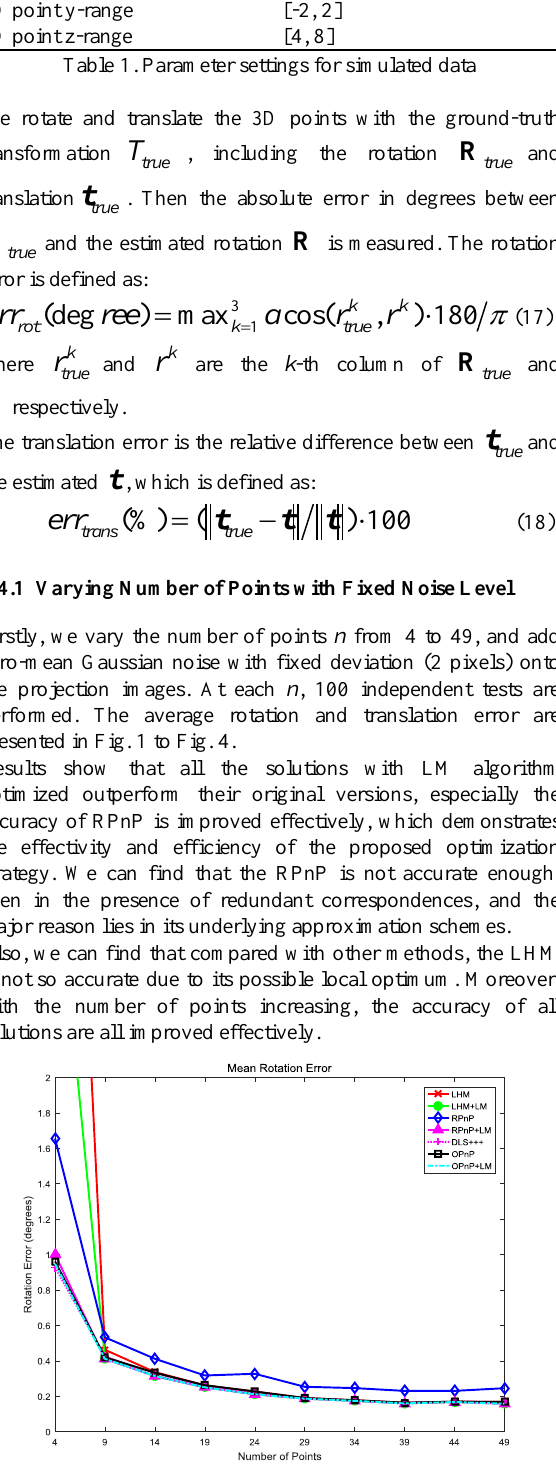
Figure 1. Mean rotation error w.r.t. varying number of points